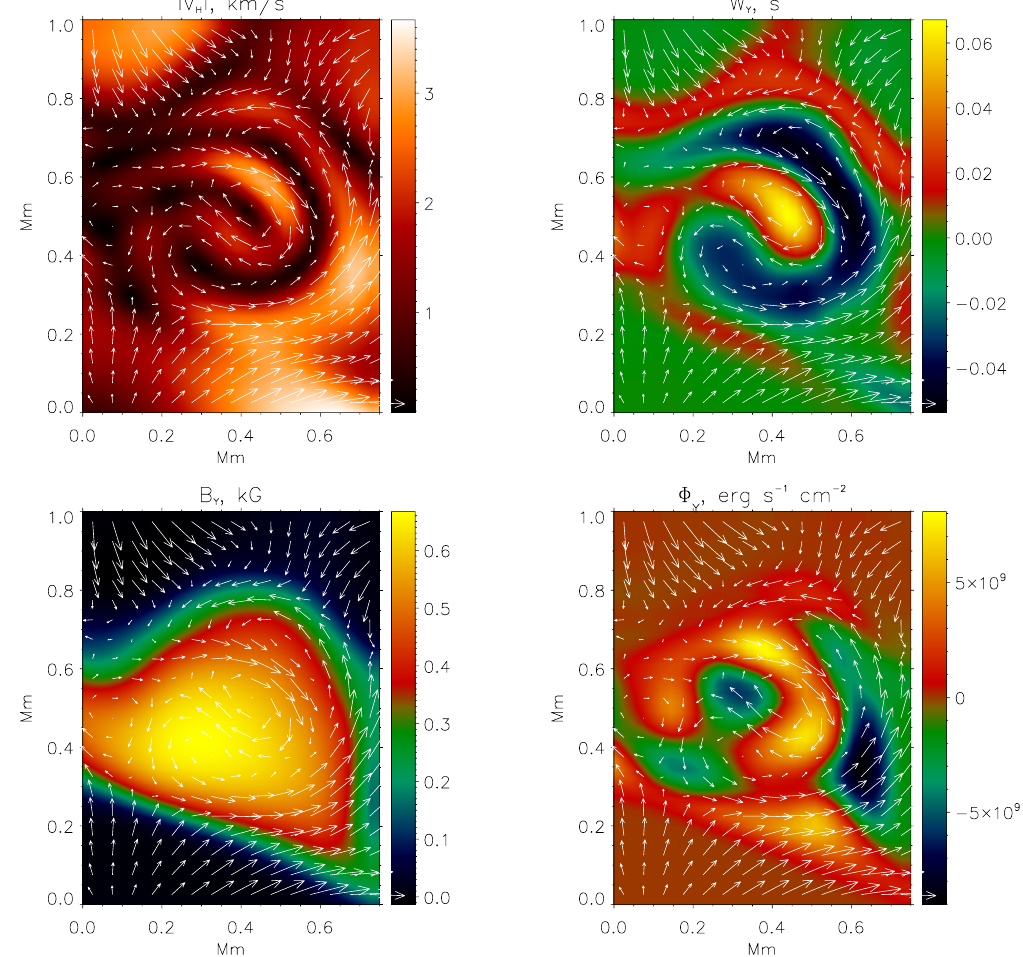
Fig. 5. A horizontal structure of the vortex. Modulus of horizontal components of velocity (top-left image), vertical component of vorticity (top-right image), strength of the vertical component of magnetic field (bottom-left image) and vertical component of Poynting flux vector (bottom-right image) are shown. The snapshots are taken in the upper photosphere at about 500km above the continuum formation level. The horizontal velocity field arrows are